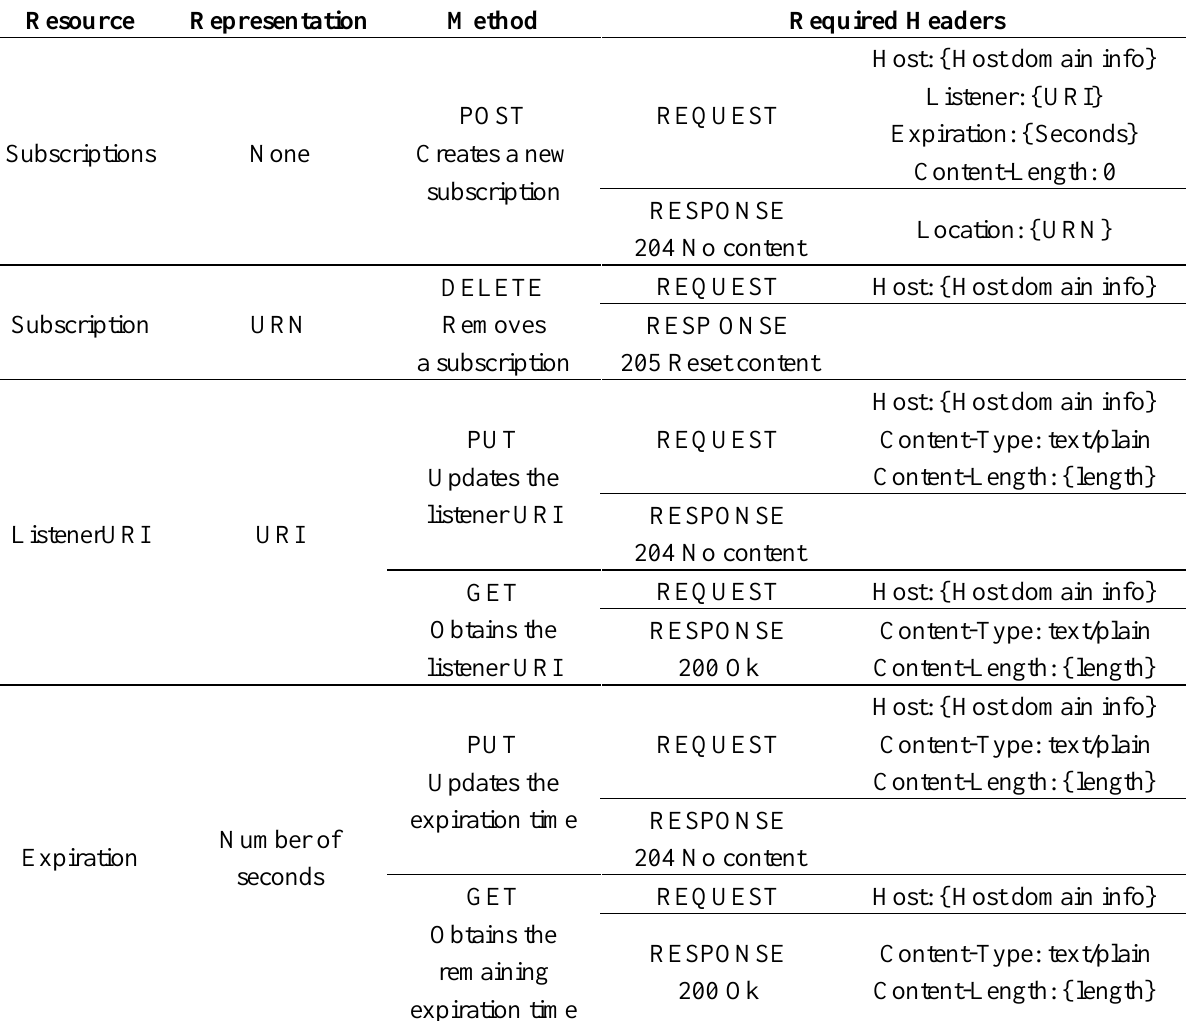
Table 2. Publisher’s resource specification detail.